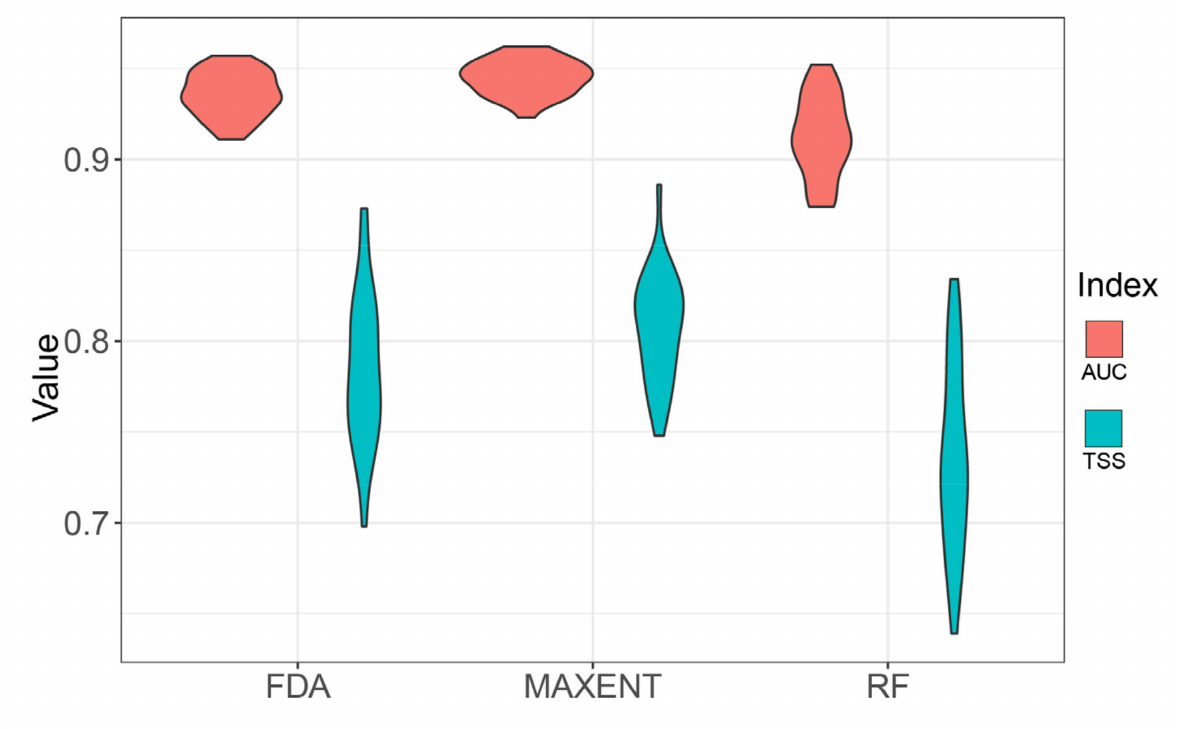
Figure 1. Model accuracy of single models applying three different